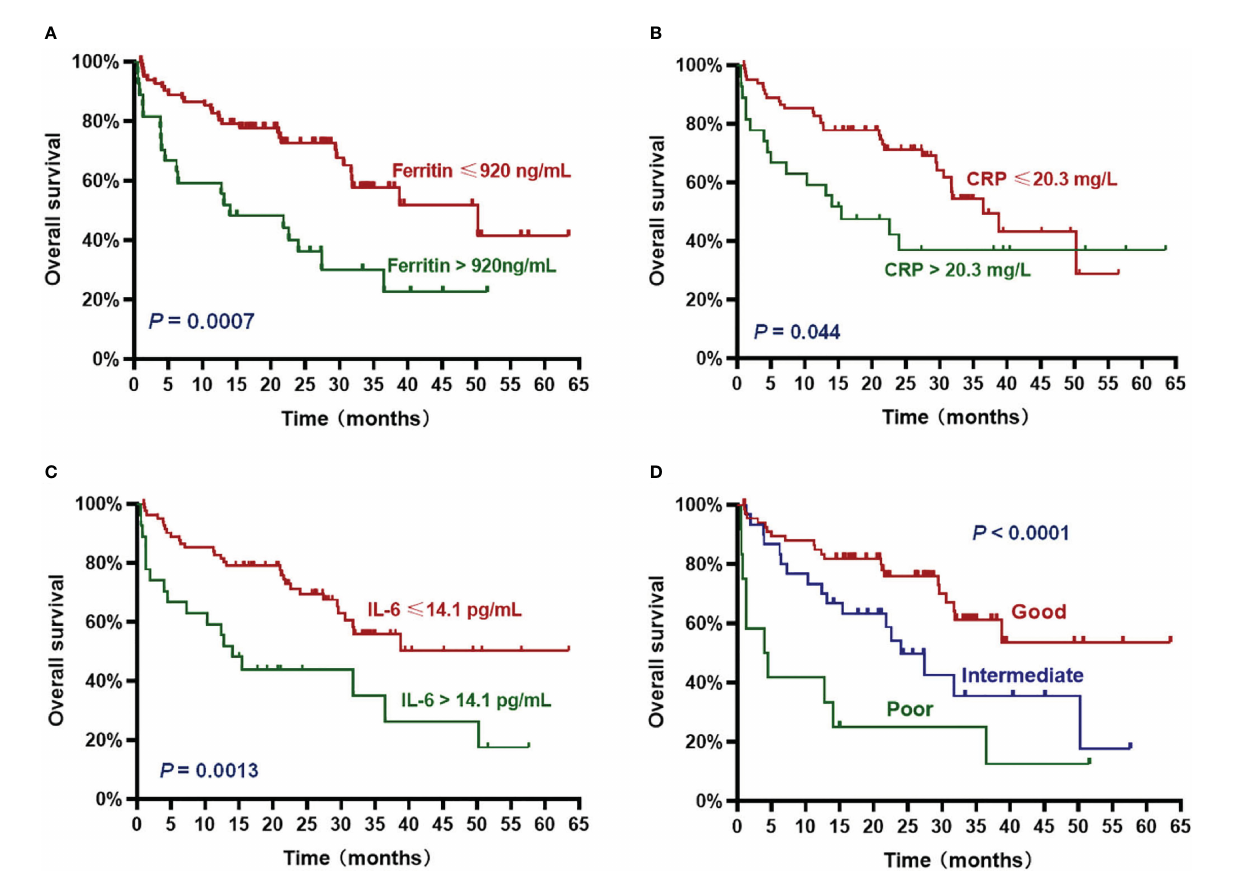
FIGURE 2 Overall survival (OS) according to in fl ammatory markers and InPI index. The patients with ferritin > 920 ng/mL (A) , CRP > 20.3 mg/L (B) , IL-6 > 14.1 pg/mL (C) and intermediate to poor InPI (D) had inferior OS. Survival curves were drawn according to the Kaplan-Meier method. The log-rank test was used to compare the difference in survival probability between two